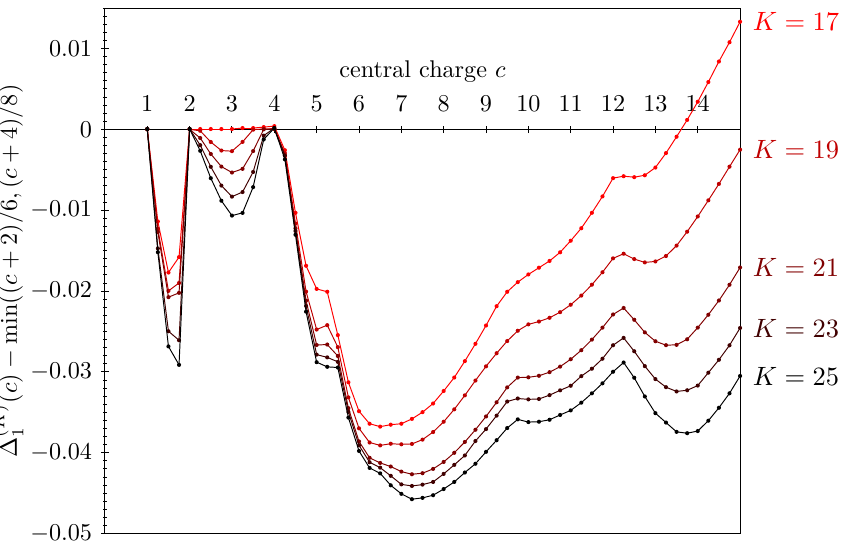
(cid:0) c +2 (cid:1) , c +4 . 6 8 WZW model. At c = 2 1